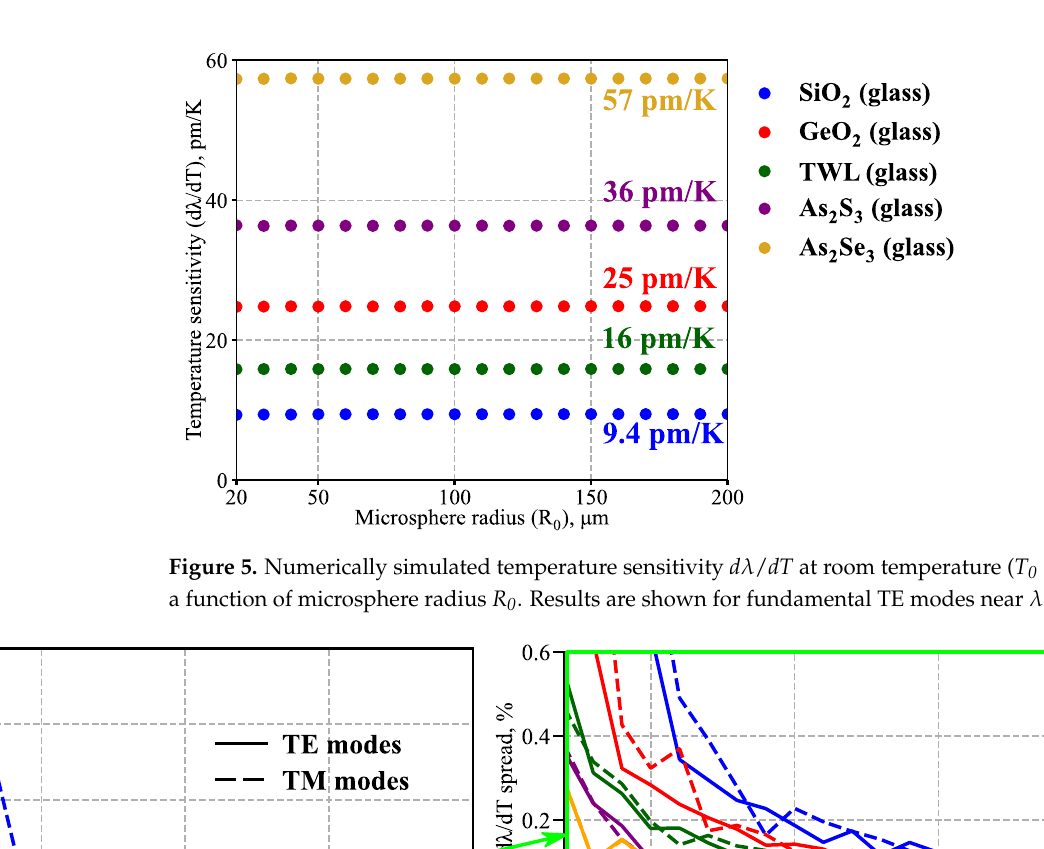
Figure 5. Numerically simulated temperature sensitivity d λ / dT at room temperature ( T 0 = 293 K) as a function of microsphere radius R 0 . Results are shown for fundamental TE modes near λ = 1.55 μ m.